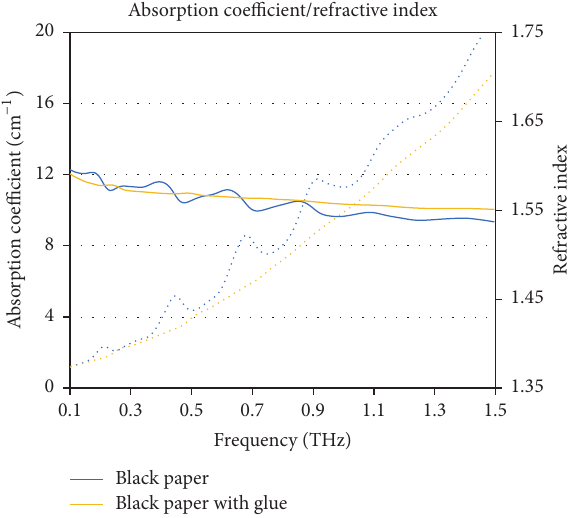
Figure 2: Absorption coefficient (dotted lines) and refractive index (full lines) curves for black paper with and without glue.